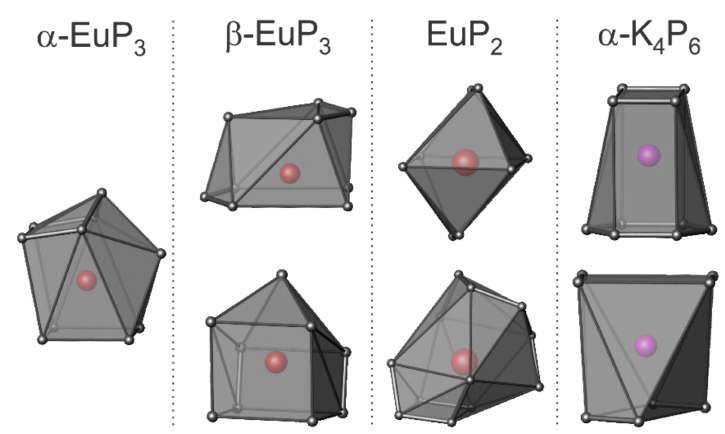
Figure 5. The cations’ coordination in EuP 3 phases, EuP 2 , and α -K 4 P 6 . P atoms are shown in gray, Eu atoms are red, and K atoms are